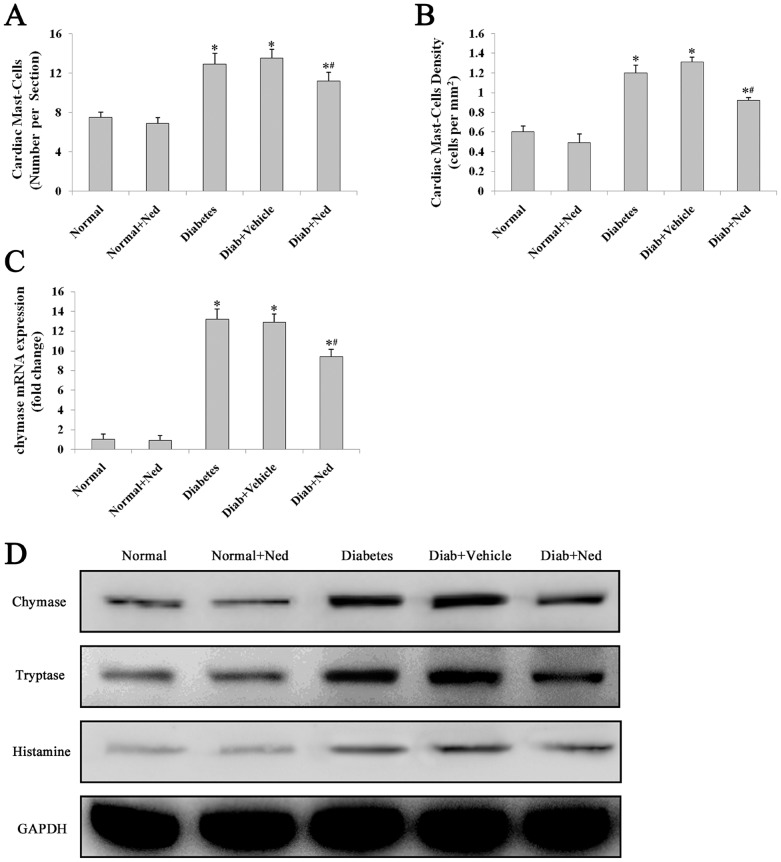
Characterization of cardiac mast cell activation in normal or STZ-induced diabetic mice after nedocromil (Ned) treatments.(A) Quantification of chymase-positive mast cells. Chymase-positive cells from immunohistochemically stained cardiac tissues were counted in 100 random fields at 400X magnification. (B) Mast cell density in sample tissues was determined by dividing the number of chymase-positive cells by the total number of cells in the visual fields. (C) mRNA expression levels of chymase in sample tissues were normalized to GAPDH expression and depicted as fold-change relative to the untreated normal group. (D) Representative results of protein expression analysis for chymase, tryptase, and histamine in sample tissues using western blot. GAPDH expression is shown as loading control. Quantitative data are displayed as means ± SD (n = 15 per group). *P<0.05 vs. untreated normal group; #P<0.05 vs. untreated diabetic group.